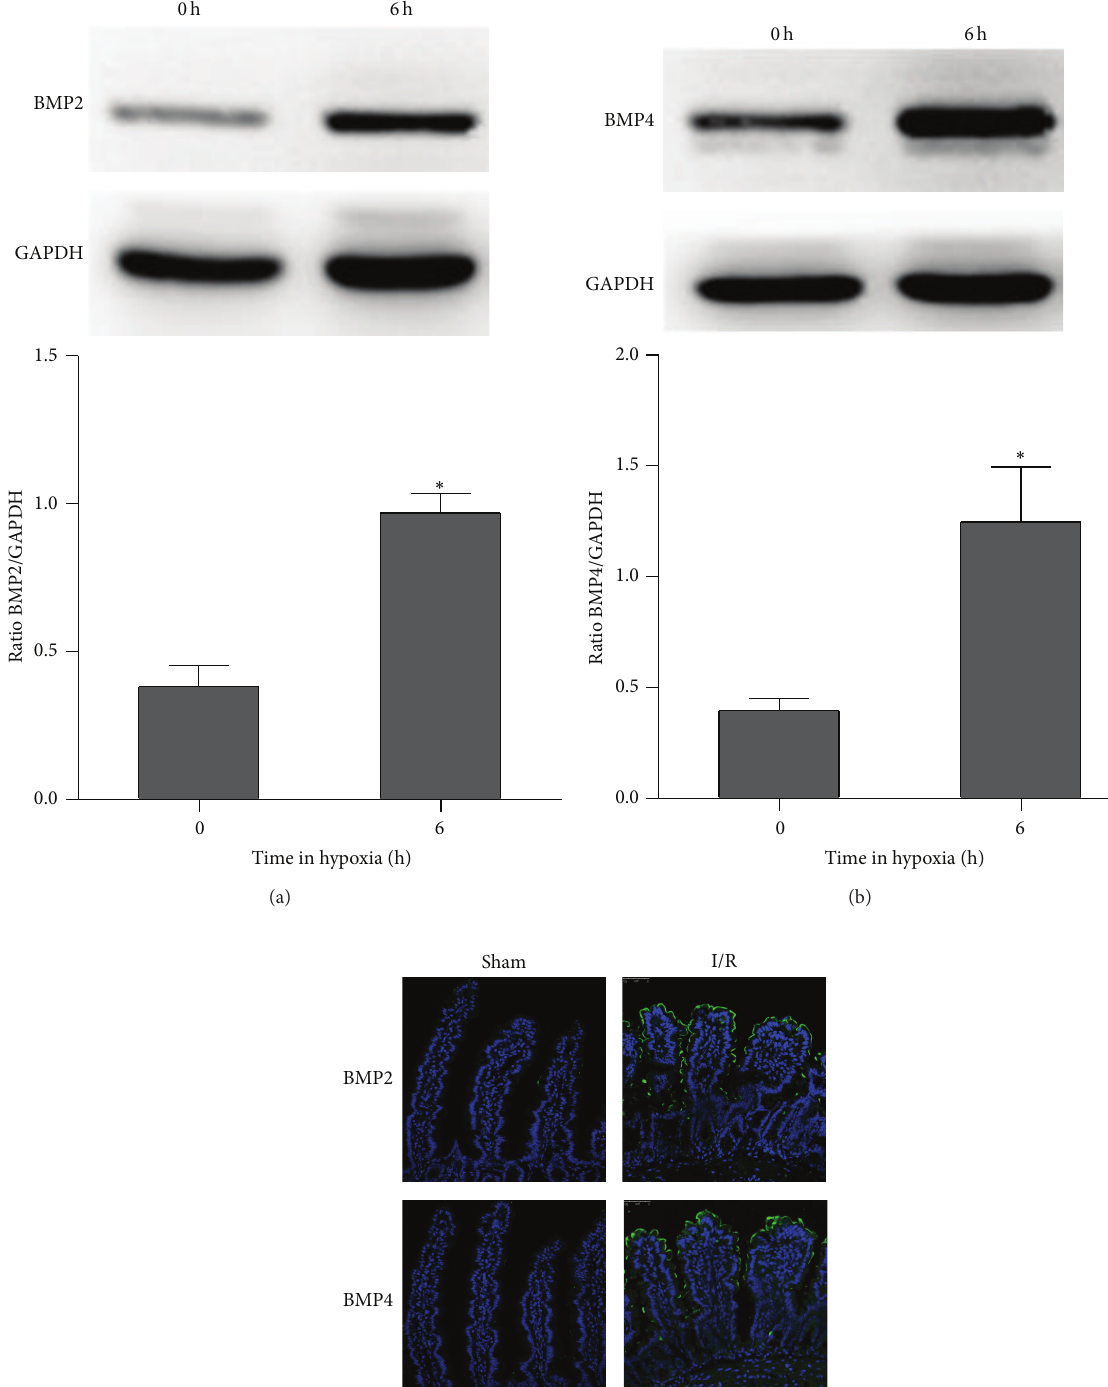
Figure 1: The expression of BMP2 and BMP4 in intestinal epithelial cells. (a) and (b) The IEC-6 cells were treated with hypoxia (1% O 2 ) for 6 h. Hypoxia caused a dramatic increase in BMP2 and BMP4 protein expression as detected by Western blotting. ∗ 𝑃 < 0.05 versus control. Data are representative of 3 similar experiments. (c) The level of BMP2 protein expression significantly increased in the mid-to-distal villus region after 1h of I/R, while the level of BMP4 protein expression also significantly increased in both the villi and